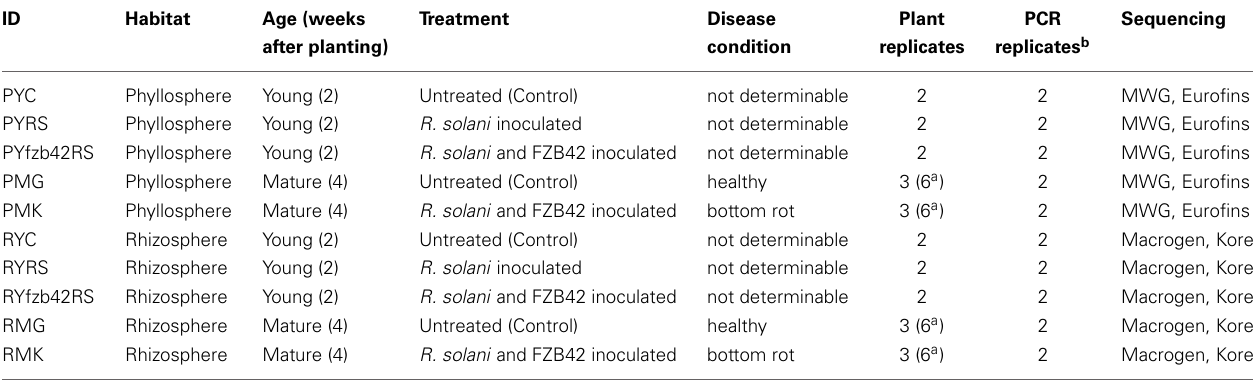
Table 1 | Sample design